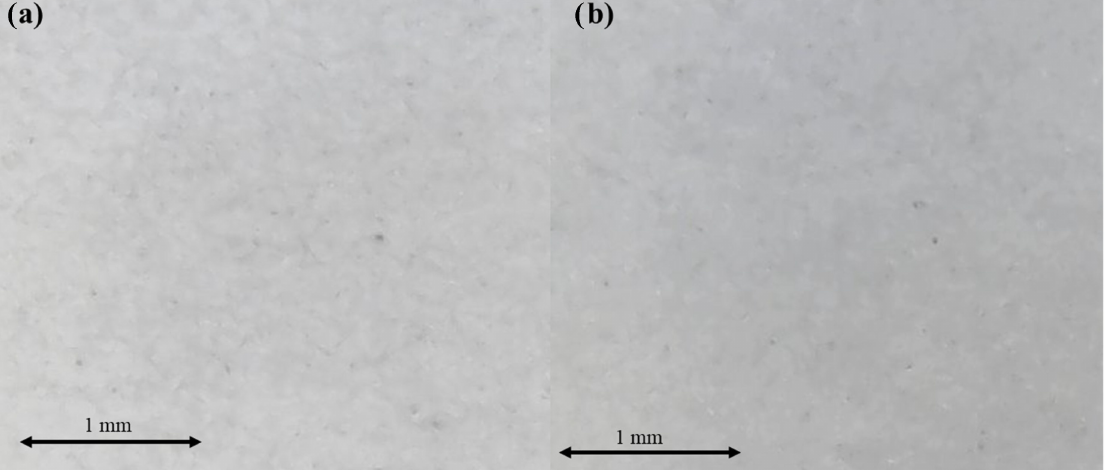
Figure 4. Digital microscope images of ( a ) unmodified Whatman 41 FP and ( b ) impregnated Whatman 41